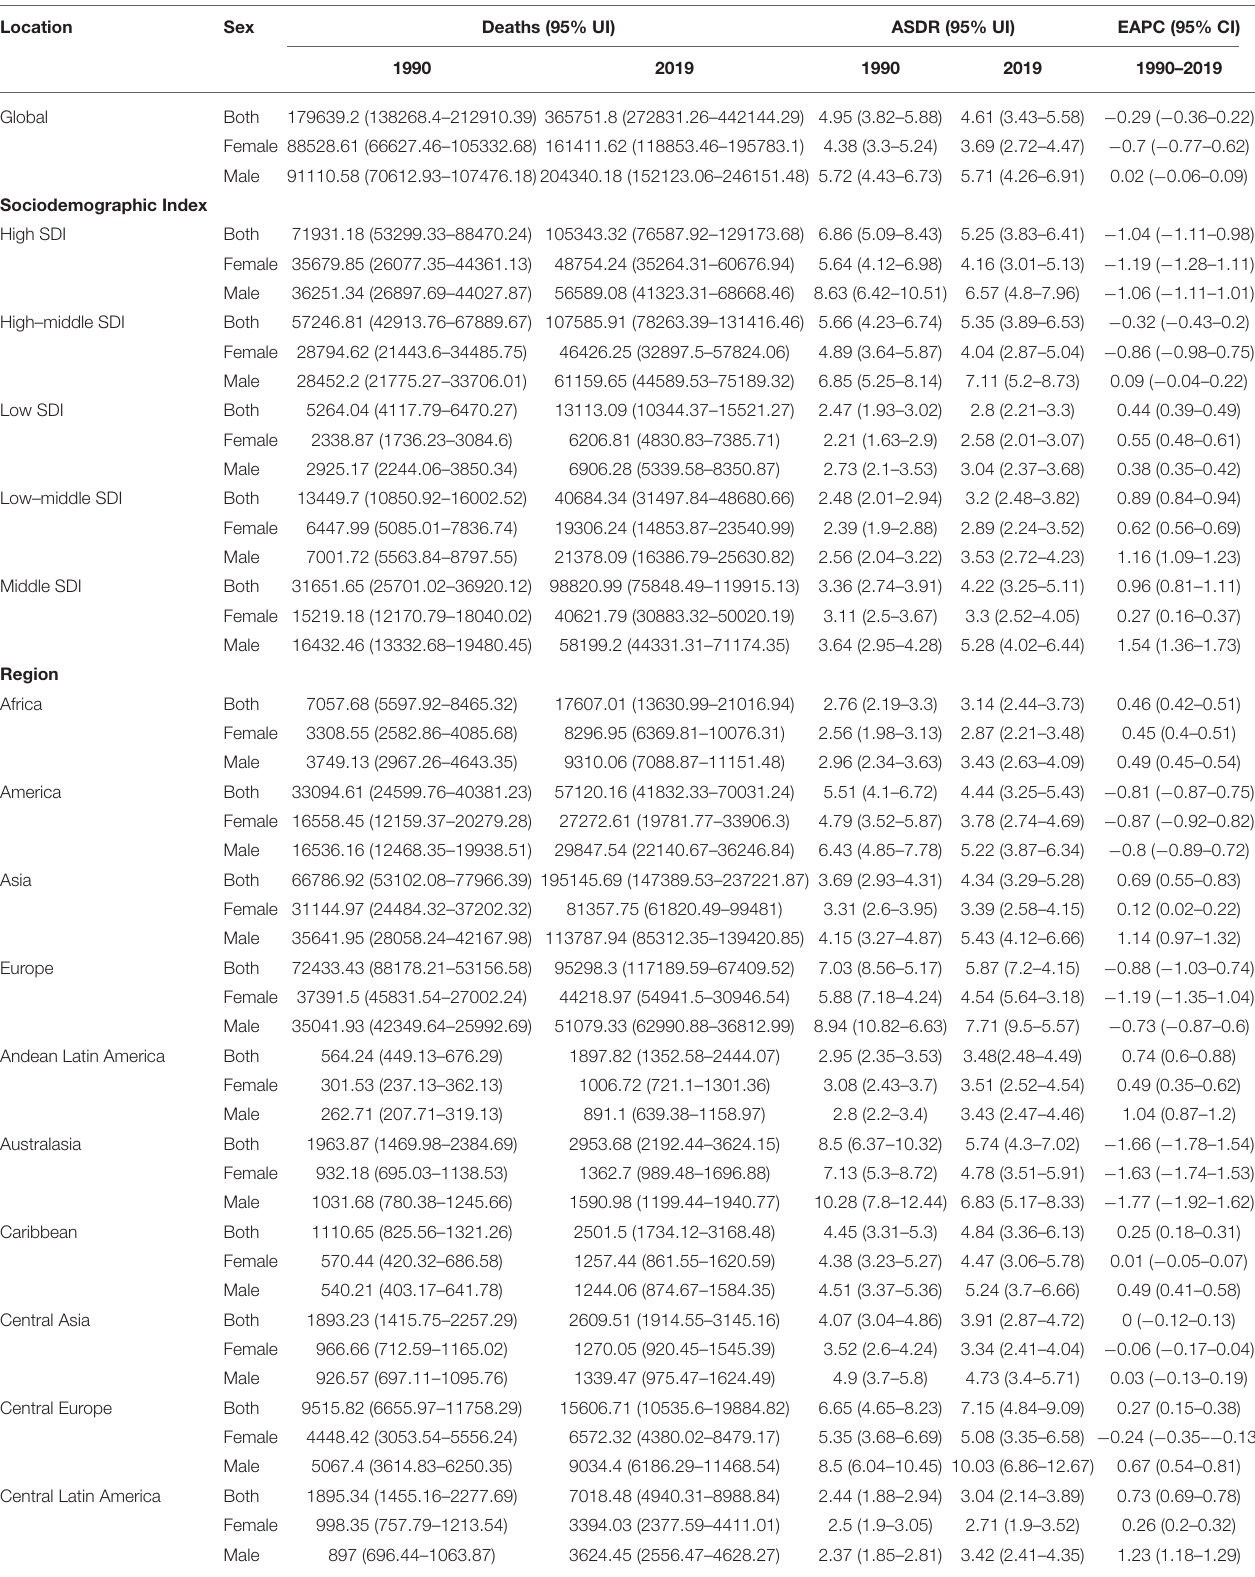
TABLE 2 | Deaths, ASDRs, and change trends of colorectal cancer attributable to dietary risks between 1990 and 2019.